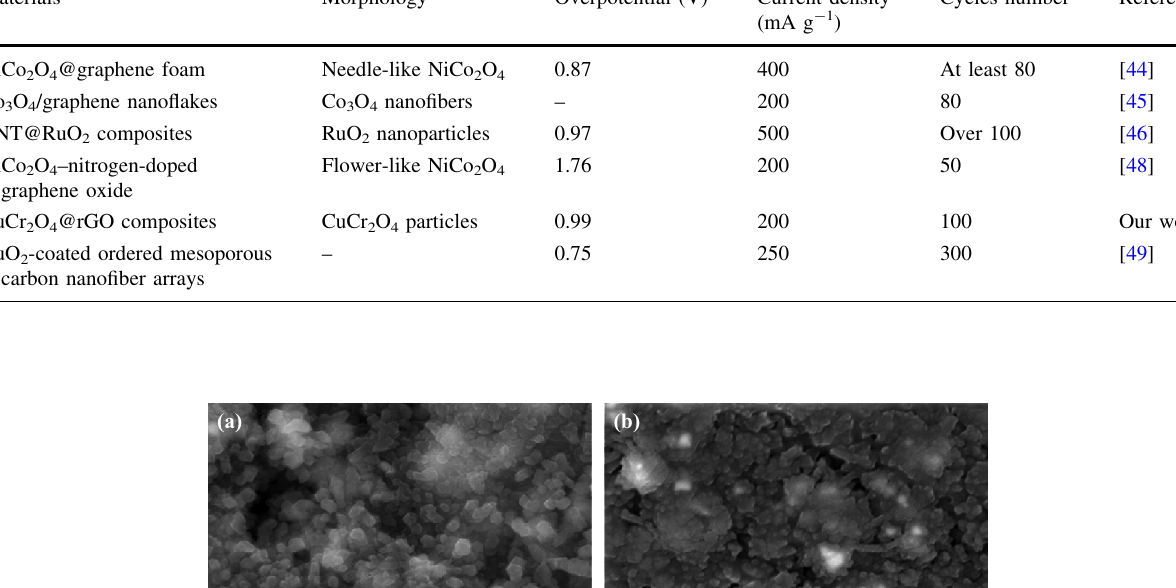
Table 1 Electrochemical properties of various spinel structure mixed transition metal oxides composites used as the cathode catalysts of LOBs with a limited capacity of 1000 mAh g - 1 Materials